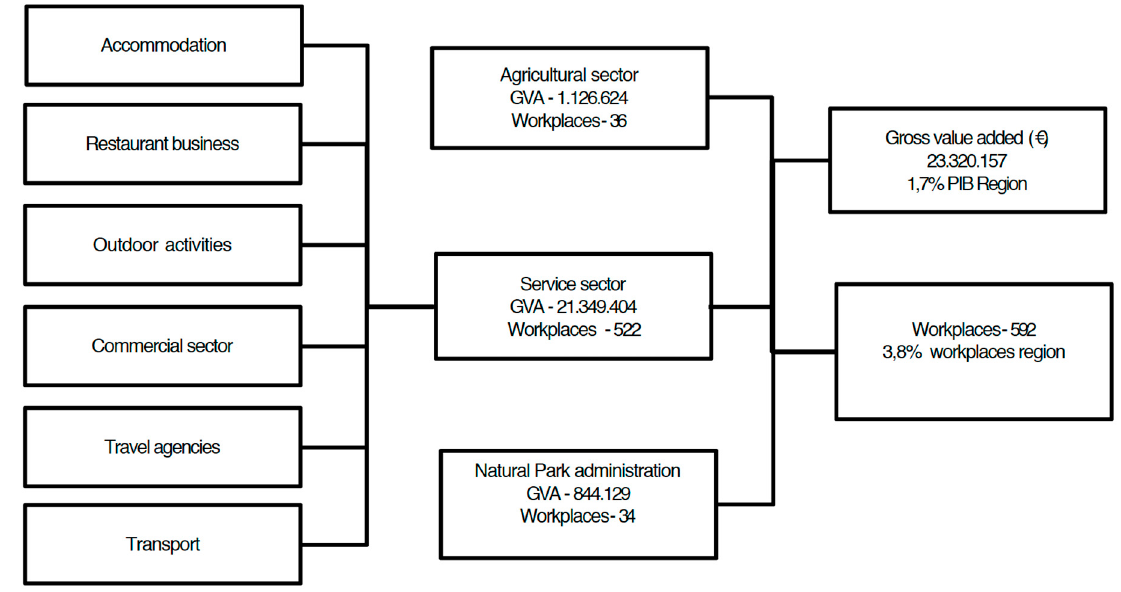
Figure 8. Calculation of the gross value added (GVA) per type of economic activity (social and economic impact of protected natural areas), jobs per types of activity, and totals (year 2012) (based on [20]).